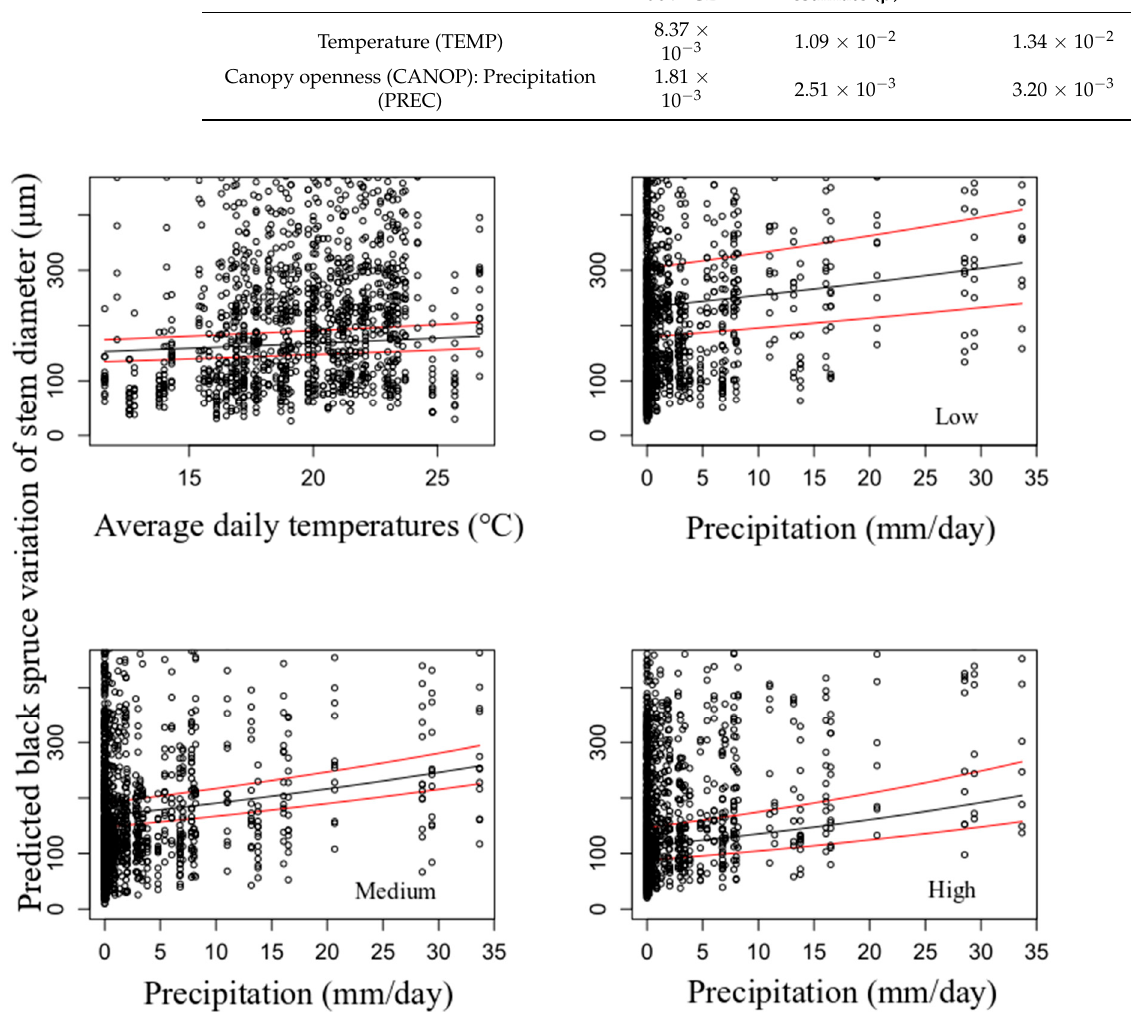
Figure 8. Predicted daily stem diameter variation of 45 black spruce that were sampled as a function of temperature and canopy openness (low = 21%; medium = 31%; high = 43%), interacting with precipitation during the 2017 growing season. Model-averaged predictions using the entire set of candidate models are included with 95% CI. Open circles correspond to the original observations. Note that in this figure, diameters were back ‐ transformed from the logarithmic scale. The figure shows the effect of variables having the greatest influence on the response variable.